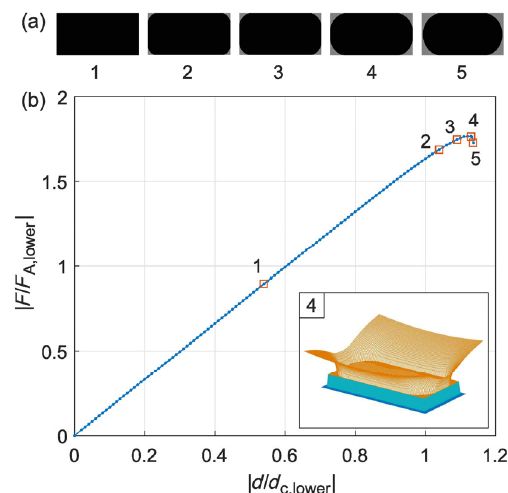
Fig. 10 Detachment of a stamp with a rectangular cross-section: (a) Consecutive shapes of the remaining contact area; the last one shown configuration corresponds to the last state of stable equilibrium. (b) The force-distance dependence. The complete detachment occurs in a configuration which strongly differs from the largest incircle of the rectangle.